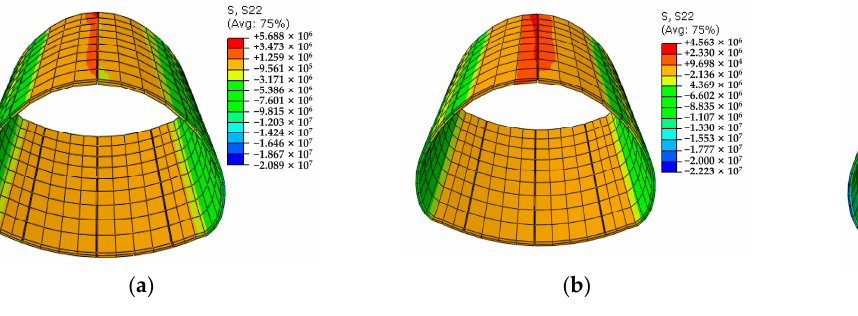
( c ) Figure 12. The vertical stress of the temporary support in different conditions (unit: Pa): ( a ) Condi- tion 1; ( b ) Condition 2; and ( c ) Condition 3. In Figure 11, the vertical stress distribution of the primary support was similar be- cause of the excavation process from the right pilot tunnel to the middle pilot tunnel in